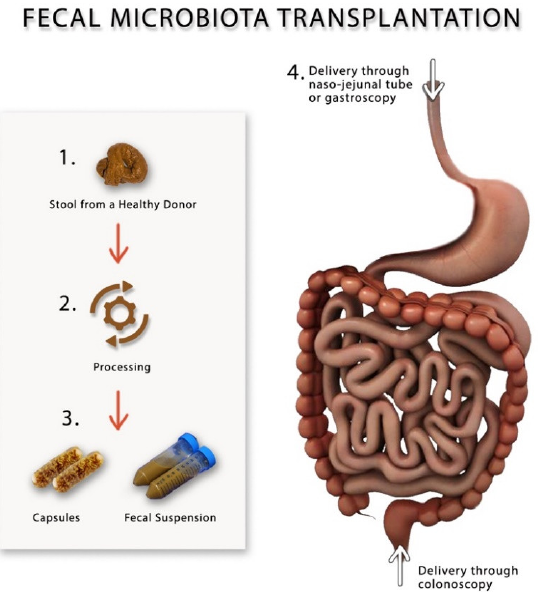
Figure 2. A schematic drawing showing different methods for preparing and performing fecal microbiota transplantation.